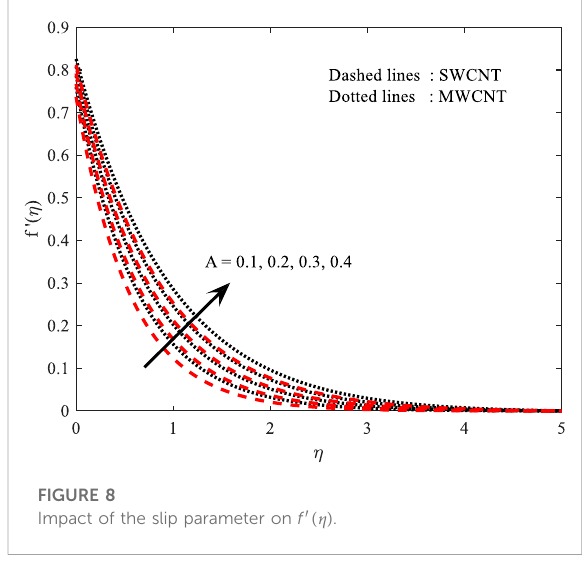
FIGURE 9 Impact of the slip parameter on F ′ ( η ) .